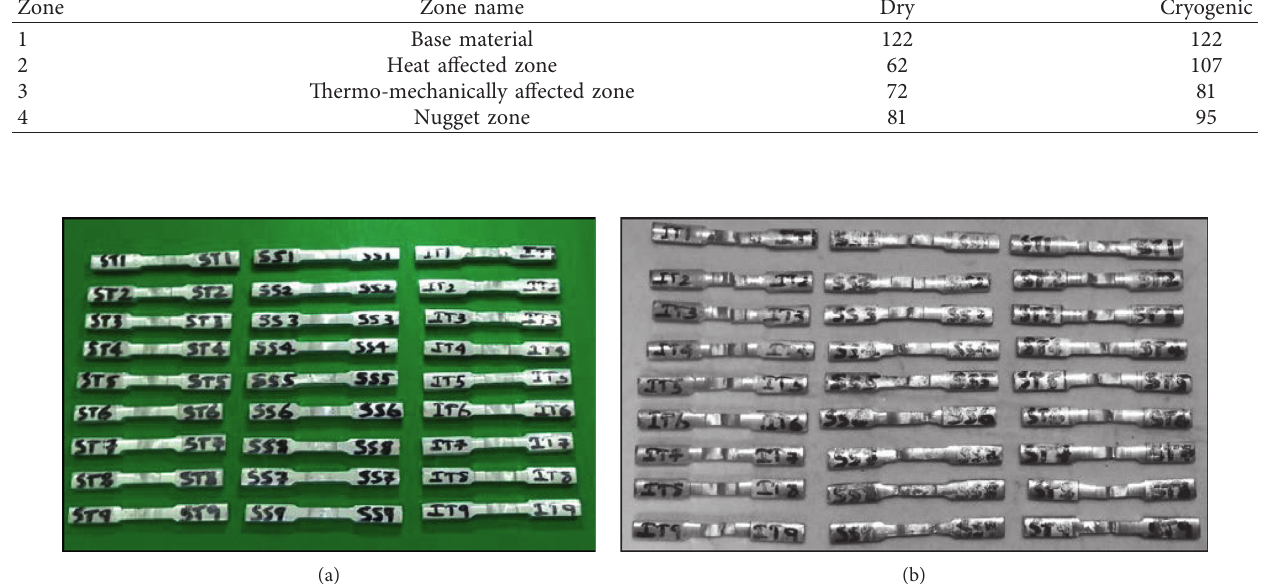
Table 10: Micro-Vickers hardness value for different zones of friction stir-welded AA 7075 alloys (a sample chosen for the disparate region). Zone